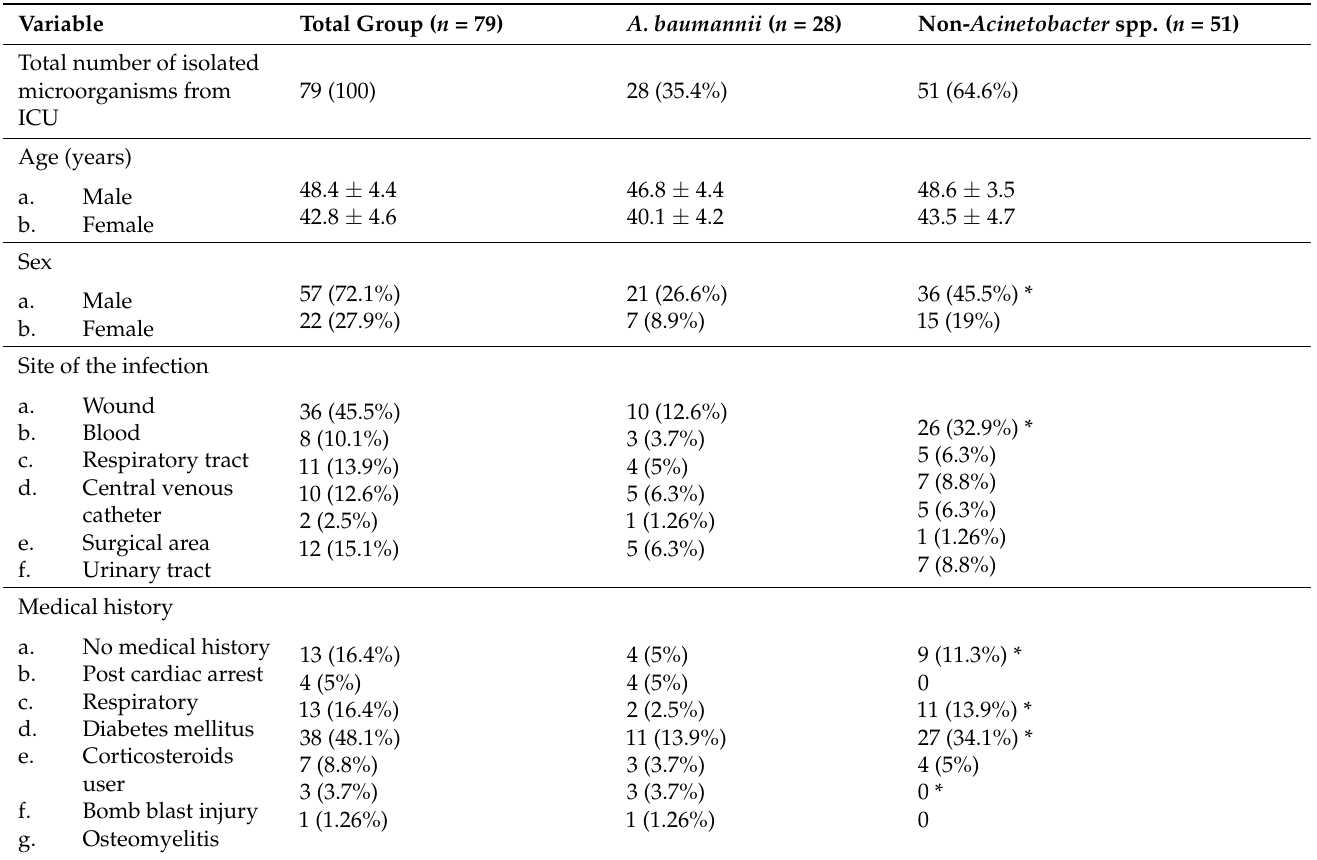
Table 1. Demographics and clinical data of the total study group, including the Acinetobacter and non- Acinetobacter species isolated from the ICU.